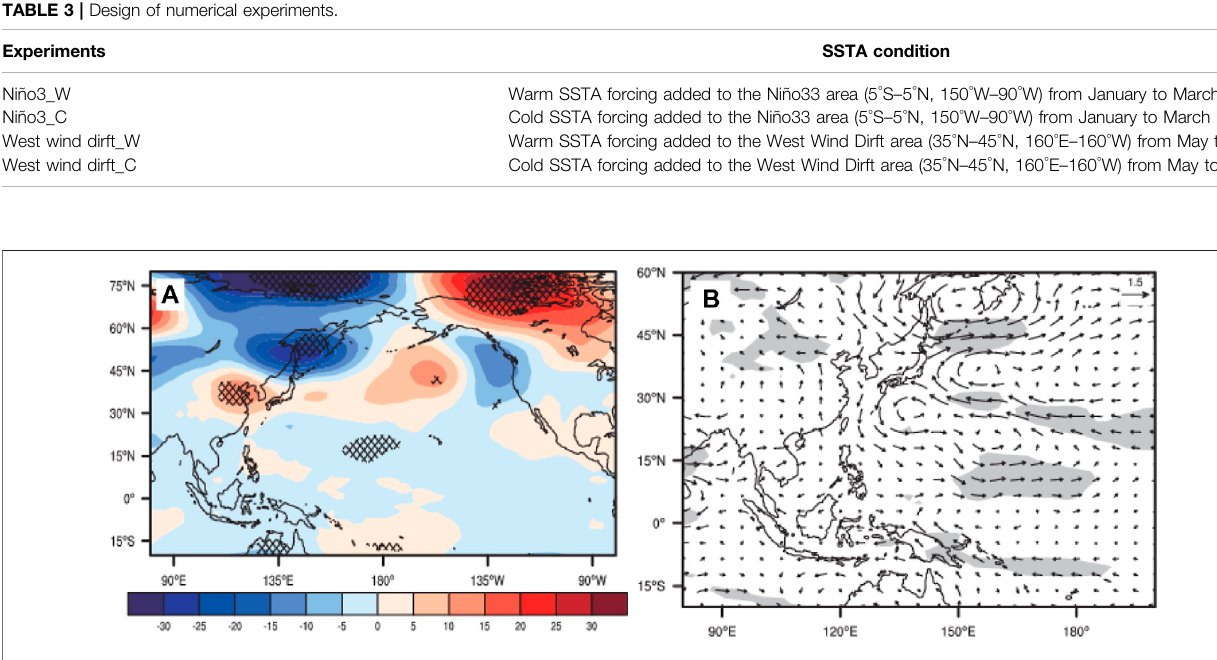
Frontiers in Earth Science |